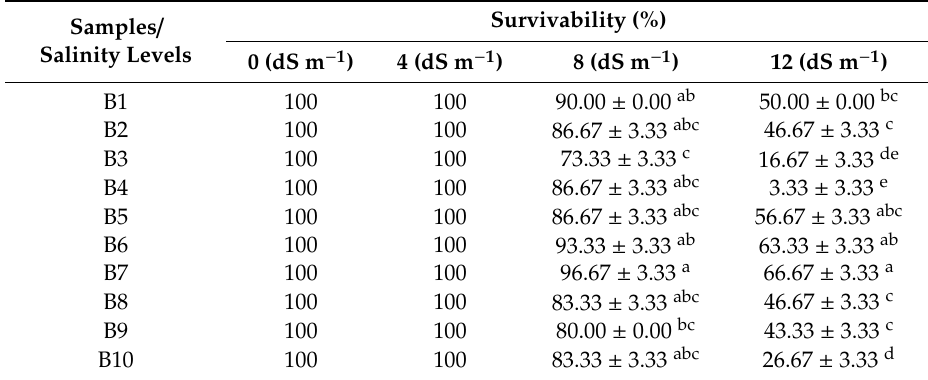
Values represent mean ± standard errors (SE) . Different letters in a column indicate a significant difference ( P < 0.05) by Tukey’s Test.